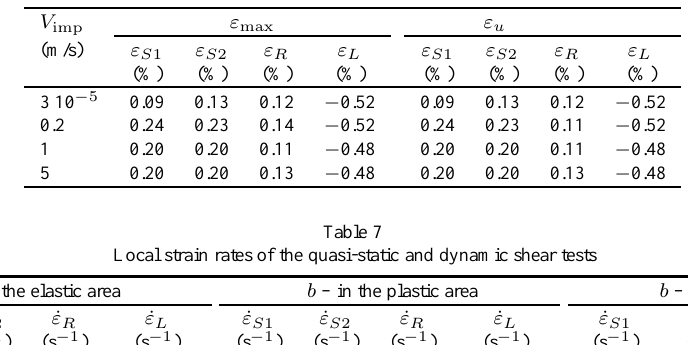
Table 6 Local results of the quasi-static and dynamic shear tests